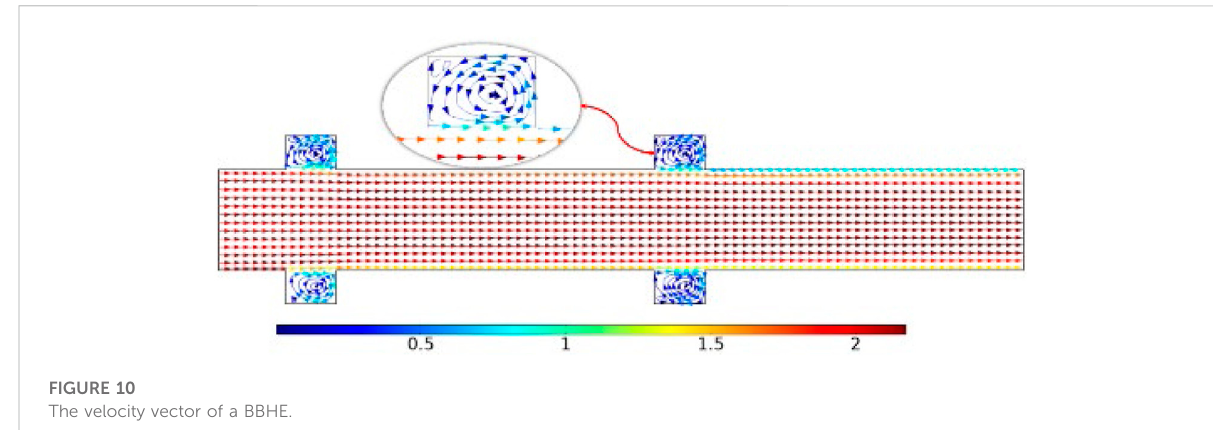
FIGURE 10 The velocity vector of a BBHE.